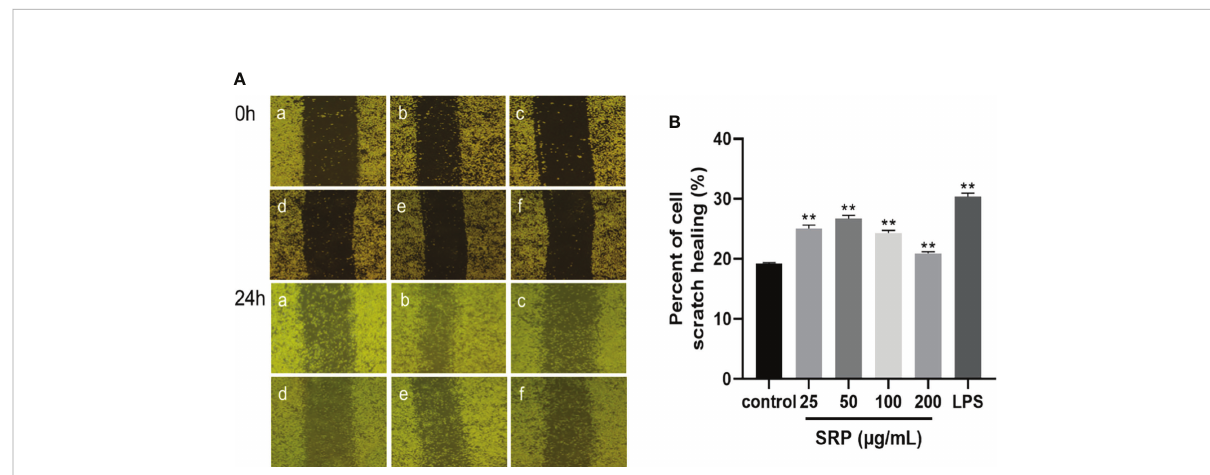
FIGURE 5 Results of the macrophages RAW264.7 scratch experiment. (A) Image of the cell scratch: a-f indicates the control, LPS, SRP (25, 50, 100, 200 m g/mL) groups; (B) Percent of cell scratch healing. Signi fi cant differences with the control group: * p < 0.05 and ** p <